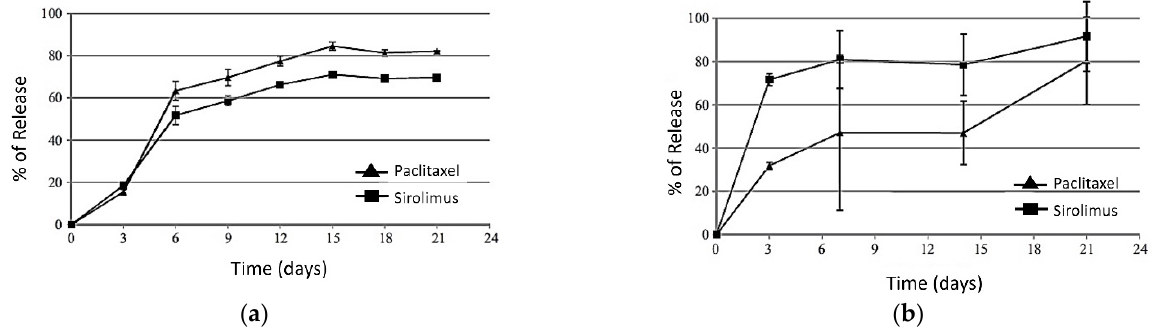
Figure 14. ( a ) In vitro and ( b ) in vivo, release profiles of paclitaxel and sirolimus from PLGA/ACP coated stents, reprinted from [81].